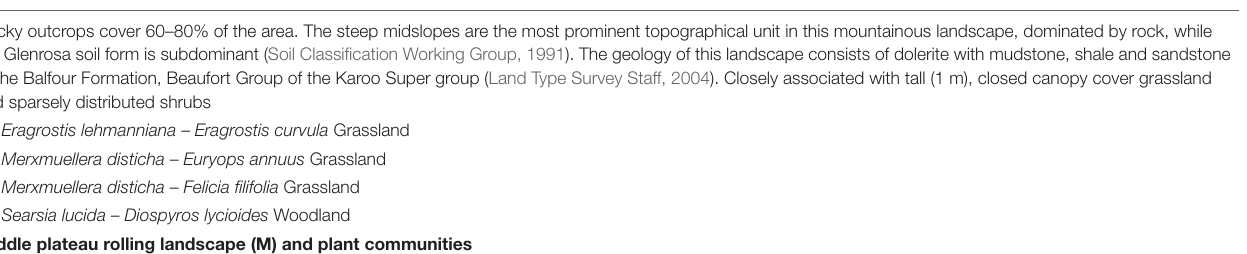
TABLE 3 | Summary of landscape and plant communities of MZNP (Bezuidenhout et al., 2015). Mountain highlands rugged landscape (B) and plant communities Rocky outcrops cover 60–80% of the area. The steep midslopes are the most prominent topographical unit in this mountainous landscape, dominated by rock, while the Glenrosa soil form is subdominant (Soil Classification Working Group, 1991). The geology of this landscape consists of dolerite with mudstone, shale and sandstone of the Balfour Formation, Beaufort Group of the Karoo Super group (Land Type Survey Staff, 2004). Closely associated with tall (1 m), closed canopy cover grassland and sparsely distributed